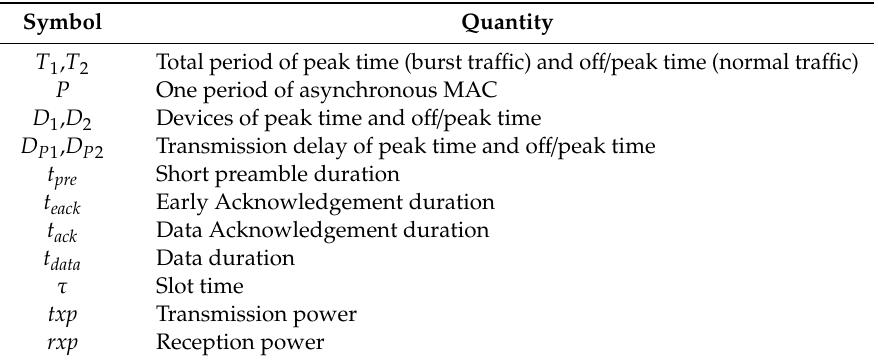
Table 1. Symbols for equations: asynchronous MAC